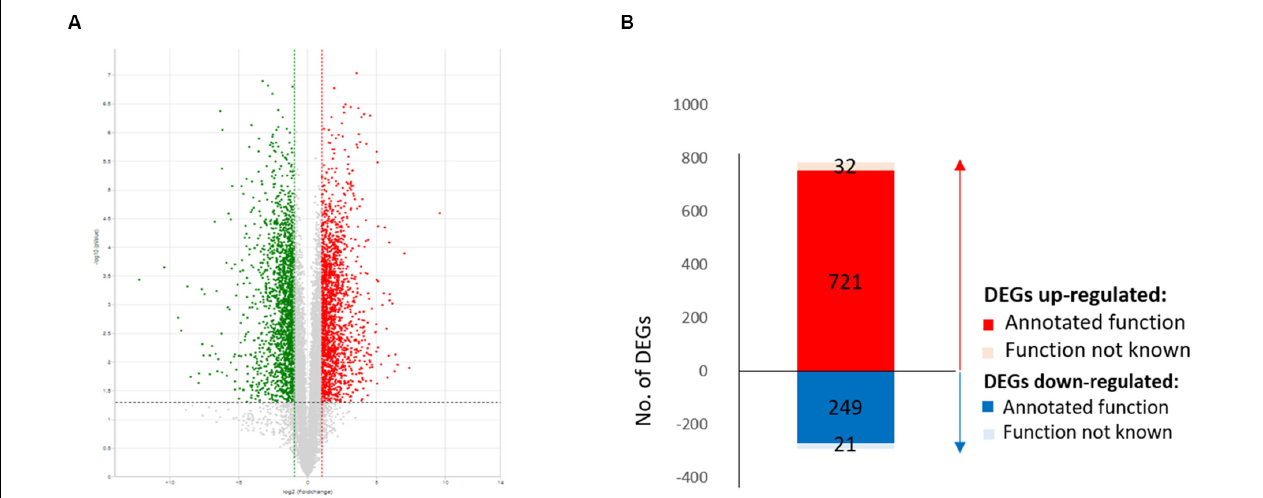
FIGURE 1 | Differentially expressed gene (DEG) profiles of wild-type EP155/2 and hypovirus-infected UEP1. (A) Volcano plot showing the means ( x -axis) and log 2 ratios ( y -axis) of genes sequenced in EP155/2 and UEP1. Red and green dots denote up- and downregulated genes, respectively, and black dots indicate genes with no significant expression. (B) Total number of DEGs (fold change > | 2|, FDR ≤ 0.01); up- and down-regulated DEGs are shown with red and blue lettering,